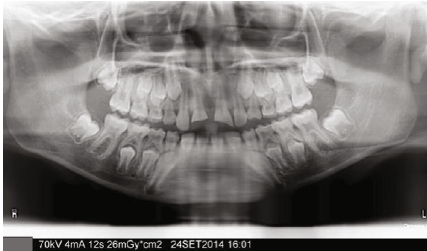
Figure 4: Panoramic radiography 3 days after